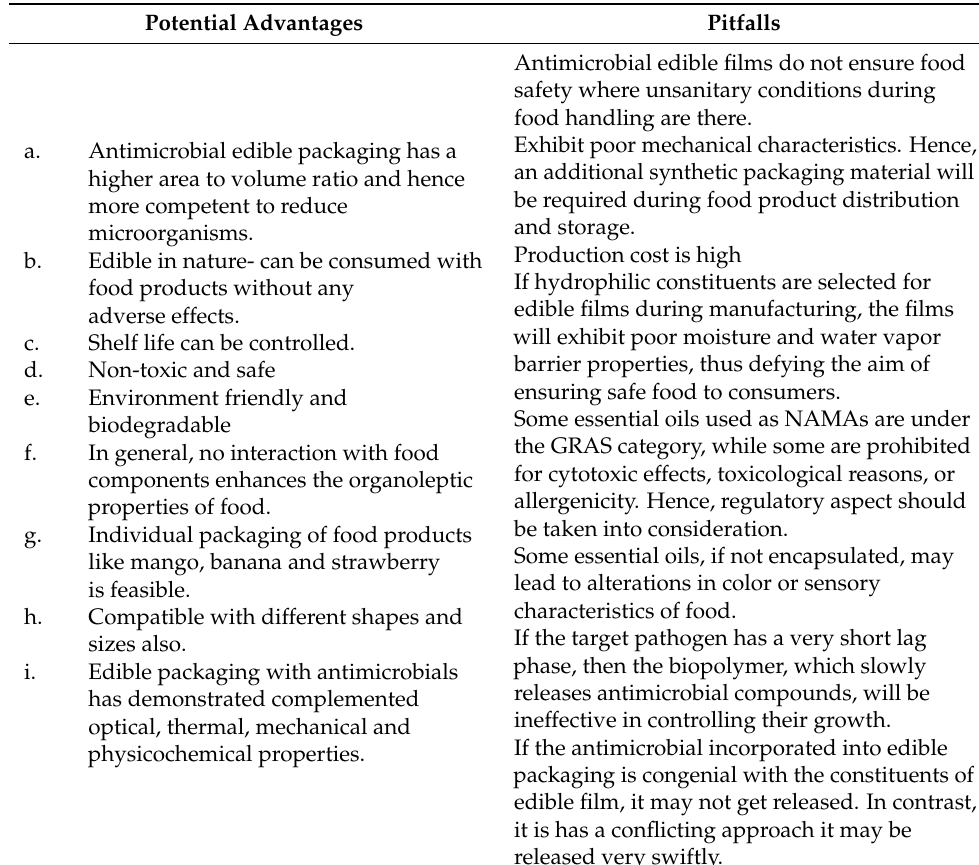
Table 3. Potential advantages and pitfalls of NAMAs in edible